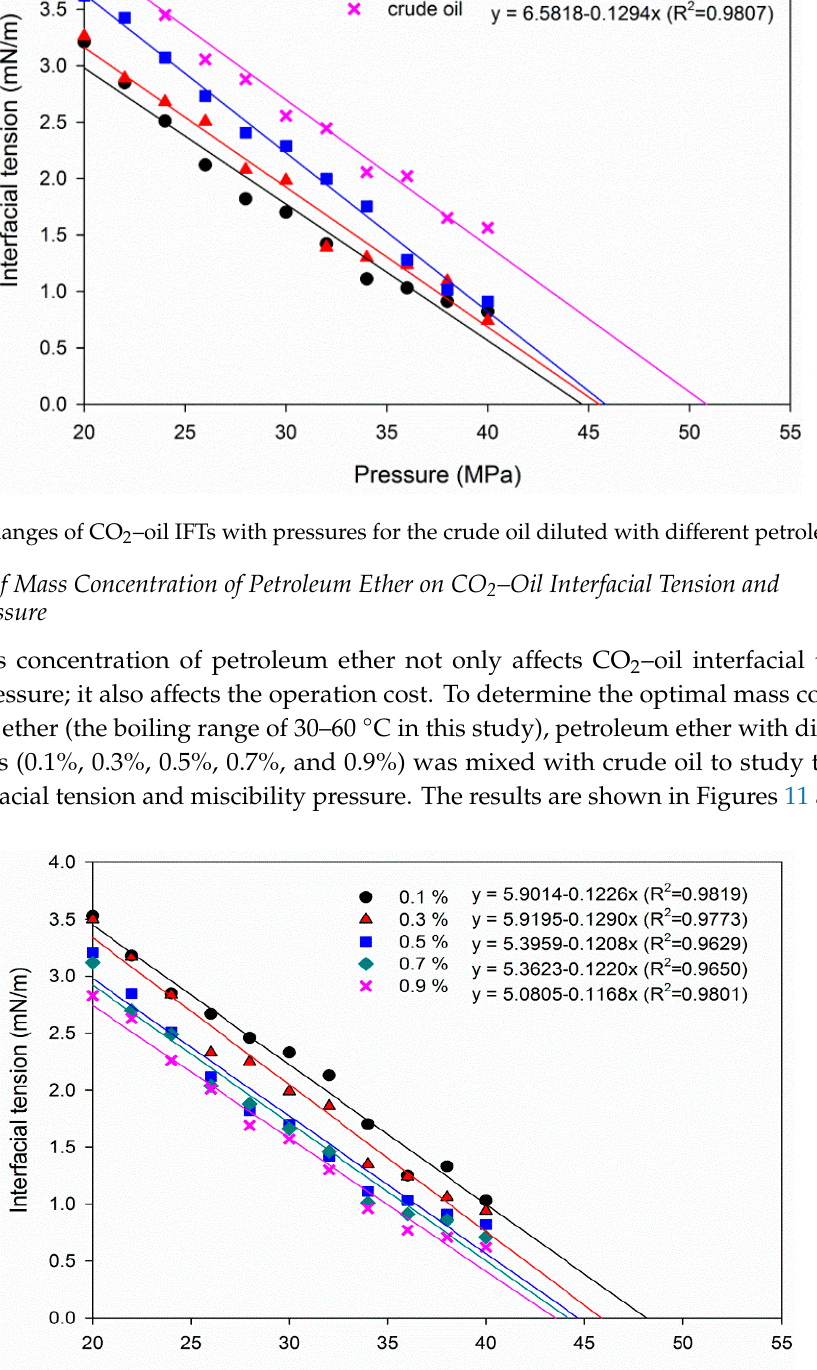
Figure 12. CO 2 –oil MMPs for the crude oil diluted with different mass concentrations of petroleum ether in the boiling range of 30 ‒ 60 °C. 3.3. Influence of Hydrocarbon Agents on Crude Oil Viscosity Different hydrocarbon agents with a mass concentration of 0.5% were mixed with crude oil, and their viscosities under different temperatures were measured (Table 3). The oil viscosity had a strong sensitivity to temperature within the scope of 40 ‒ 50 °C, and it declined slowly when the temperature exceeded 50 °C. Table 3. Oil viscosities for the diluted crude oil with different hydrocarbon agents and undiluted crude oil under different temperatures. Temperature ( o C)